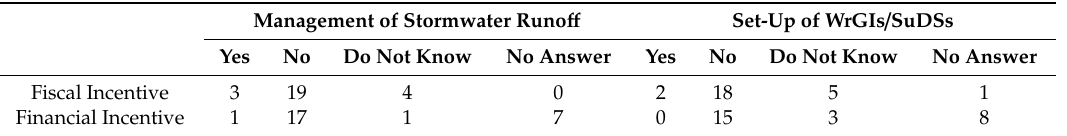
Table 3. Fiscal and financial incentives for supporting the management of stormwater runo ff and the set-up of WrGIs / SuDSs).